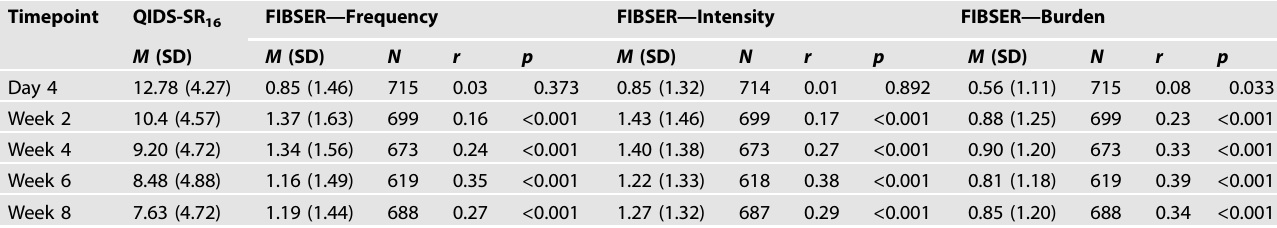
Table 2. Correlations between QIDS-SR 16 scores and FIBSER scores at each study timepoint.